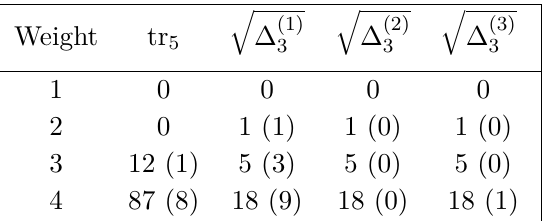
Table 5. Number of one-mass pentagon-functions with negative Z 2 charge with respect to each of the square roots. In parentheses are the corresponding numbers for the cyclic subset specified in eq.